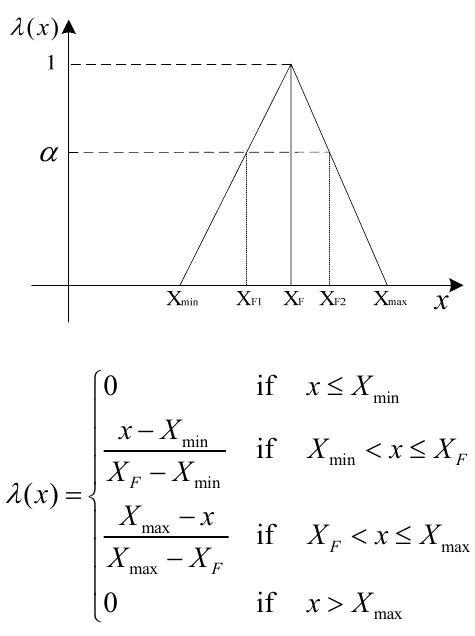
Figure 4. Fuzzy description of x